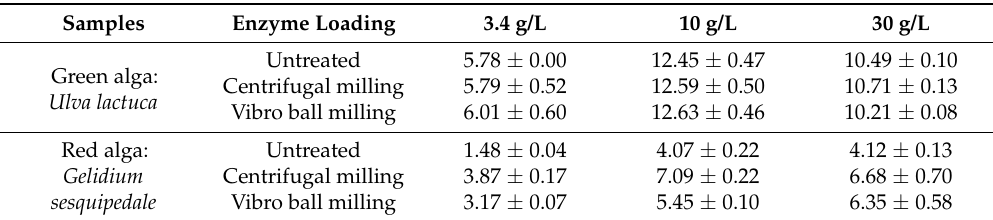
Table 3. Glucose yield (g/100 g TS) obtained after 72 h of enzymatic hydrolysis of untreated and milled algae with an enzyme dosage of 3.4, 10 and 30 g/L.